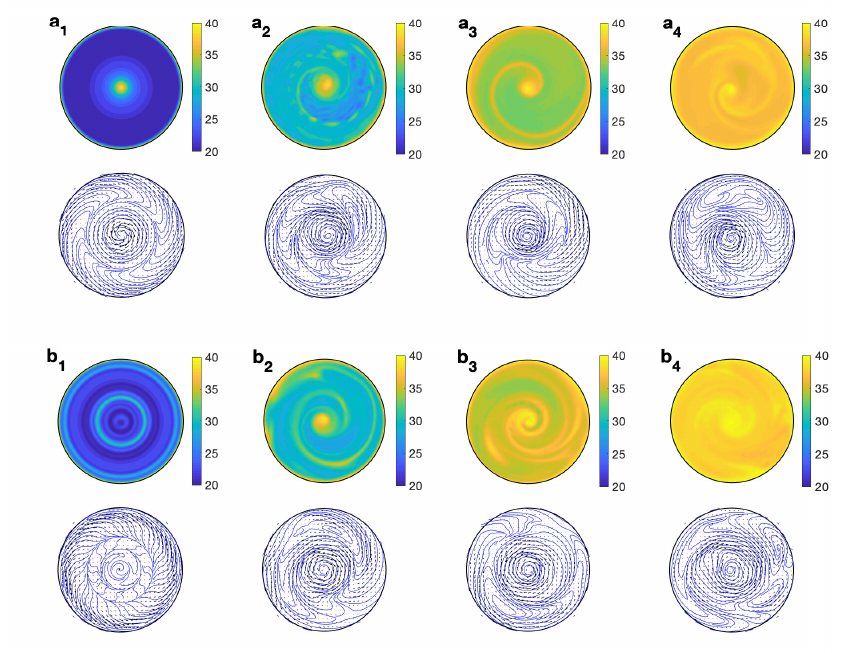
Figure 5. Contour of the predicted temperature, velocity field and streamlines for a top view at z = 0.0017 m for T e = 40 ◦ C. ( a ) Ω = π s − 1 . ( a 1 ) t = 10 s; ( a 2 ) t = 30 s; ( a 3 ) t = 50 s; ( a 4 ) t = 70 s; 100 s − 1 . ( b 1 ) t = 10 s; ( b 2 ) t = 30 s; ( b 3 ) t = 50 s; ( b 4 ) t = 70 ( b ) Ω = π 60